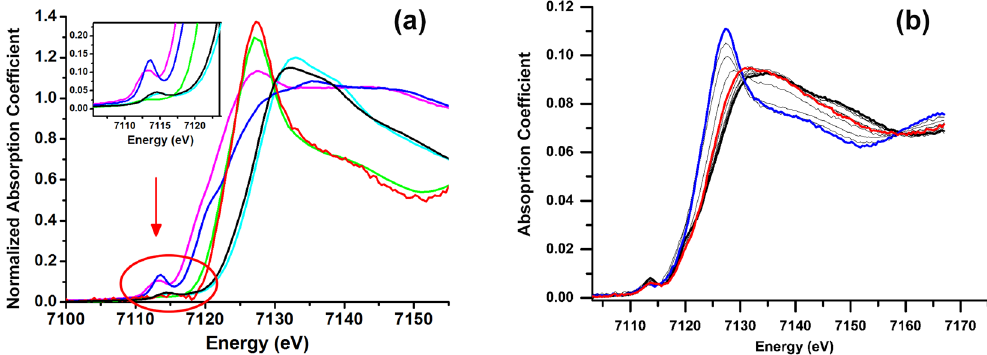
Figure 2. ( a ) Normalized XANES spectra of FeSO 4 (light green), FeCl 3 (cyan), AlkG reduced (magenta), AlkG oxidized (blue), AlkB reduced (red) and AlkB oxidized (black). The inset highlights the pre-edge absorption of AlkB oxidized , AlkG oxidized and AlkG reduced at ca. 7113 eV; ( b ) Titration of dithionite into the mixture of AlkG and AlkB with ca. 1:1 ratio (direction for the titration of dithionite, concentration from low to high: Black → Red → Blue).